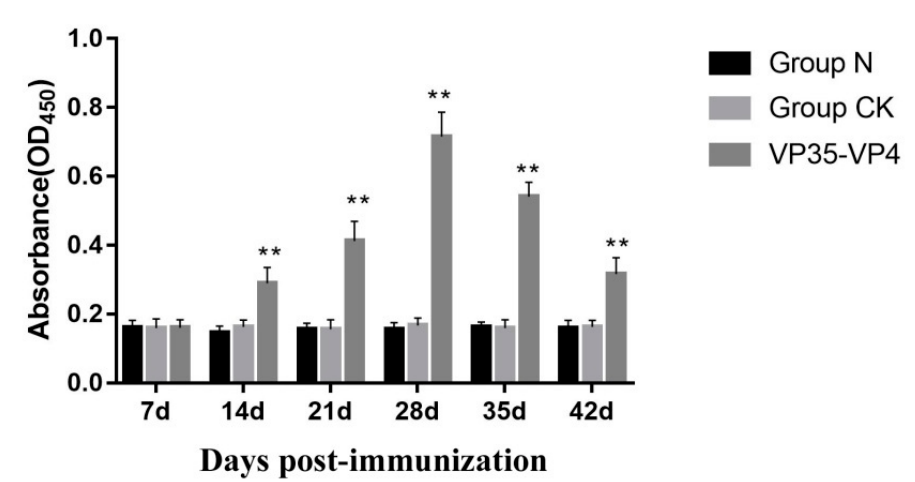
Figure 6. Change of serum IgM antibody levels in grass carp after immunized with oral vaccine. The fish serum was 1:00 dilutions. ** p < 0.01. The significant difference is compared against the CK group.